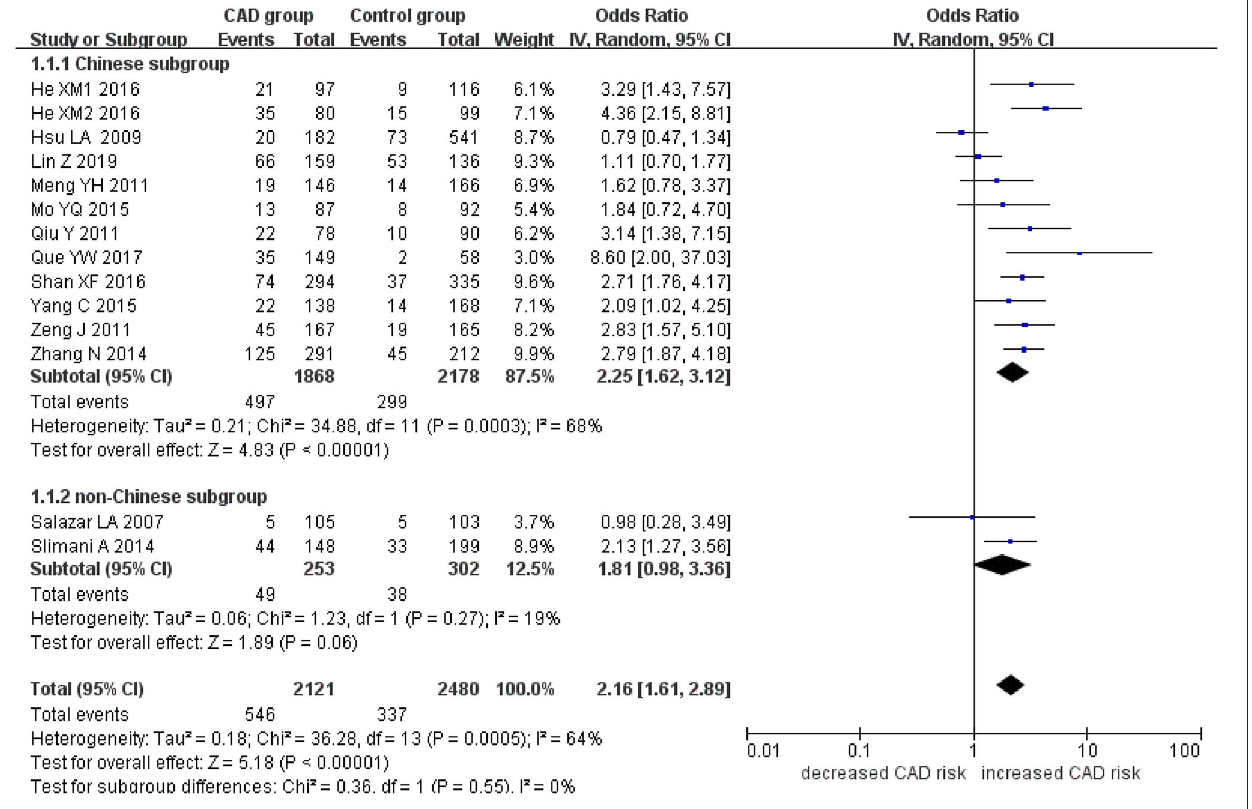
evaluated by using Egger’s linear regression test on the OR with significance set at P < 0.05 level under the allelic genetic model (20). The statistical analyses were performed by using Review Manager 5.3 and Stata 12.0 (StataCorp, College Station, TX,